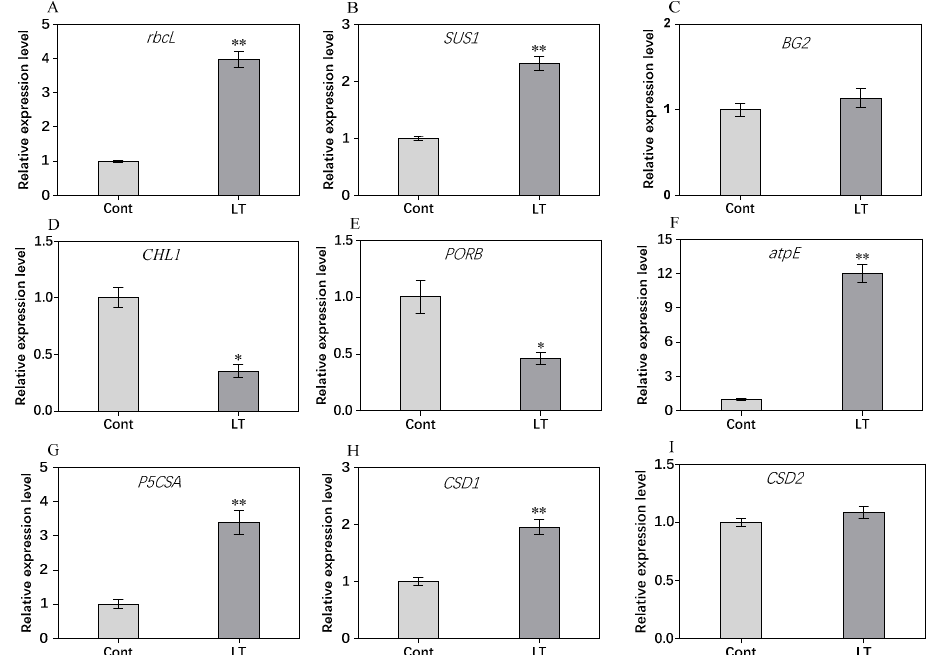
Figure 8. Transcriptional level analysis of nine genes encoding DEPs at low temperatures compared to control conditions. The transcriptional expression of the rbcL ( A ), SUS1 ( B ), BG2 ( C ), CHLI1 ( D ), PORB ( E ), atpE ( F ), P5CSA ( G ), CSD1 ( H ) and CSD2 ( I ). * represents significant at P < 0.05 , ** represents significant at P < 0.01 .